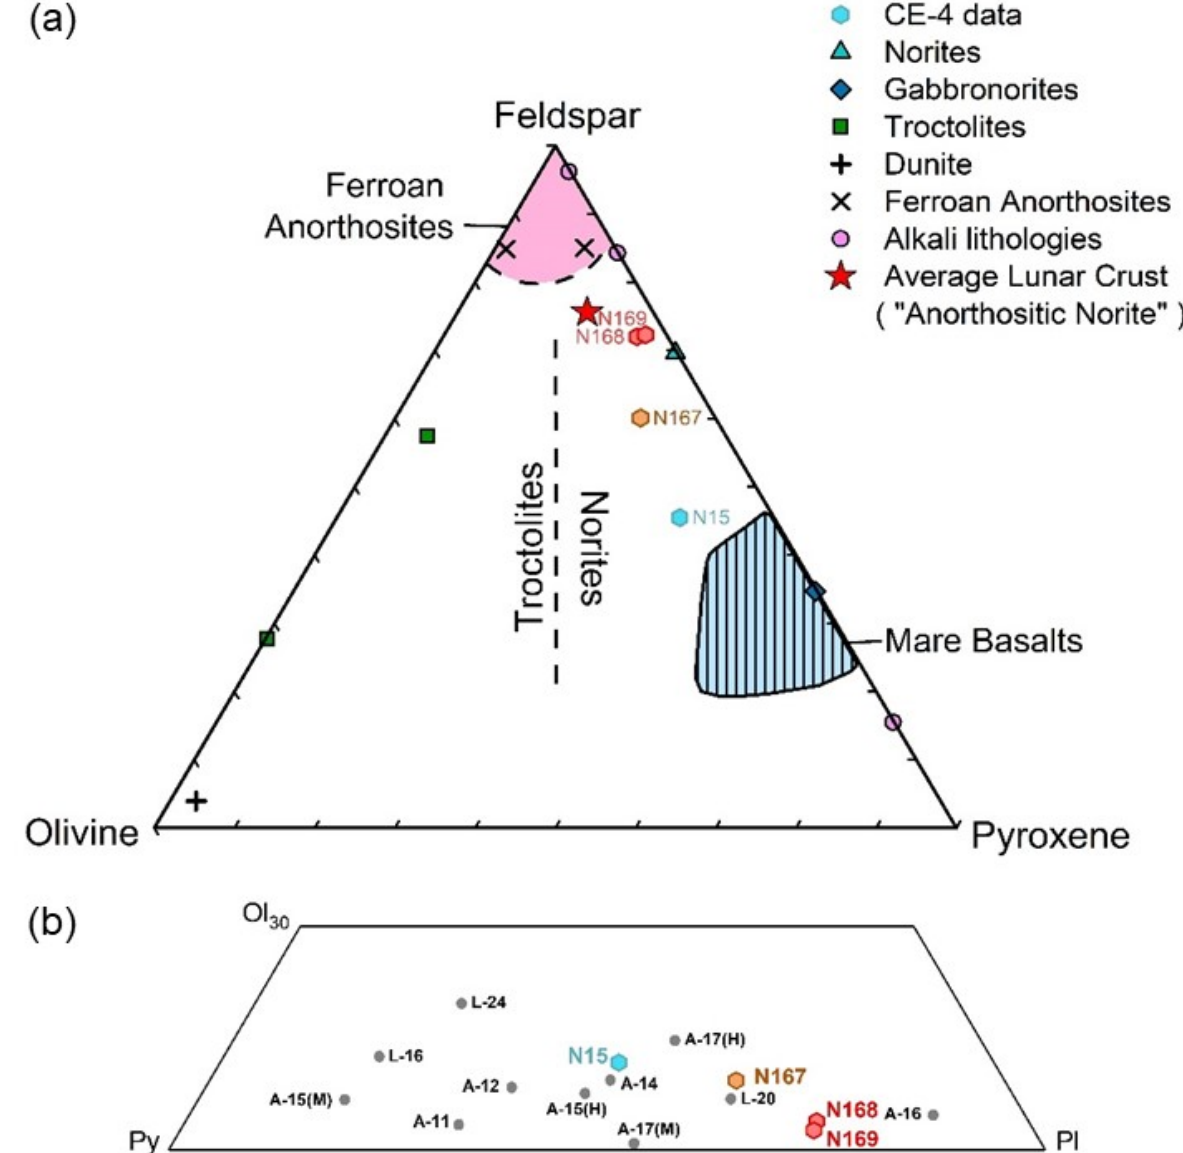
Figure 9. ( a ) Modal proportions of major minerals in the highland pristine igneous rocks and monomictic breccias [24]. ( b ) Composition of the Chang’e-4 rocks in the olivine (30%)-pyroxene-plagioclase triangle compared with data of Apollo and Luna. Sampling sites are indicated; for example, A-11 is Apollo 11 and L-16 is Luna 16. (H) and (M) indicate highland soil and mare soil, respectively.